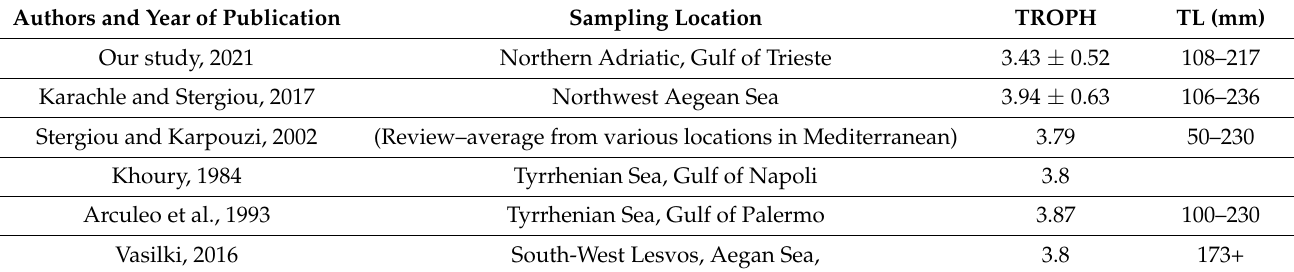
Table 9. Trophic levels of Serranus scriba in the Mediterranean